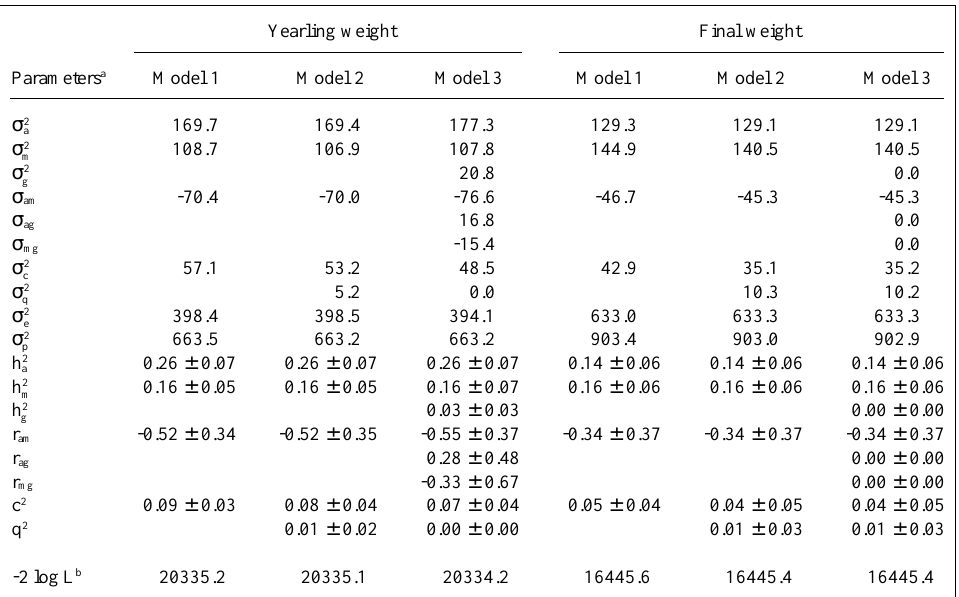
Table III - Estimates of components of variance and genetic parameters for yearling and final weights for Gobra